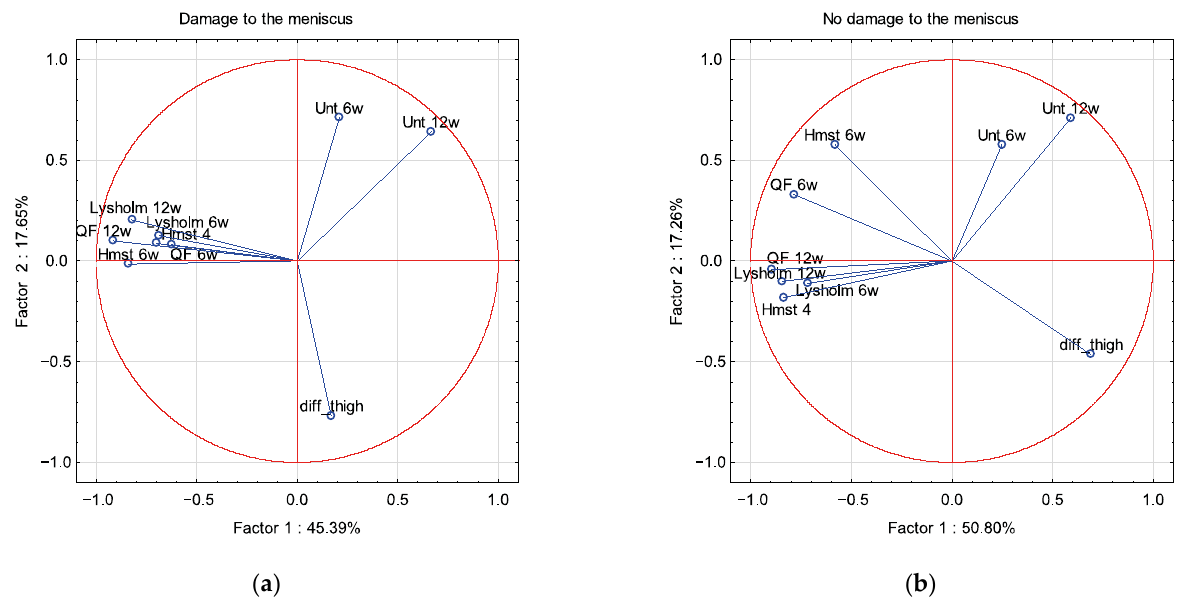
Figure 4. A graphic illustration of Principal Components Analysis of Lysholm, Unterberger test and muscle strength. Projection of the variables on the factor plane of the first two principal components for damage ( a ) and no damage ( b ) to the meniscus.